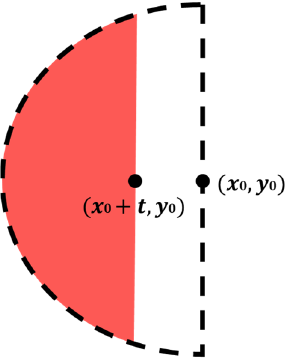
Figure 7. Compensation of ellipse spot image.